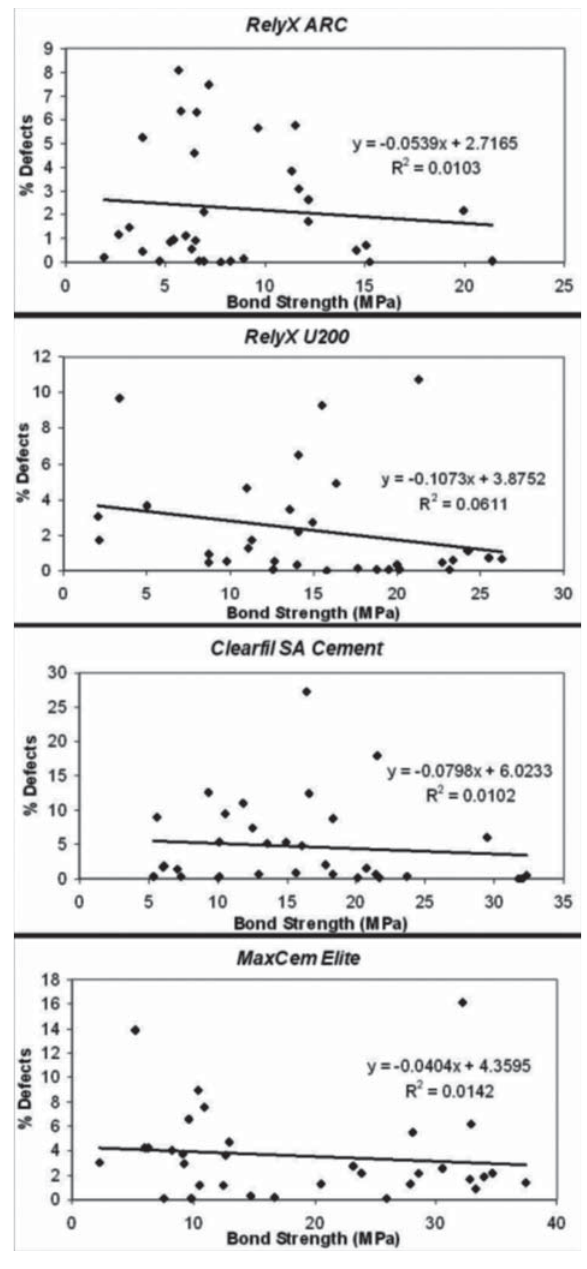
Figure 5- Regression analysis of percentage of interfacial defects vs bond strength for all resin cements